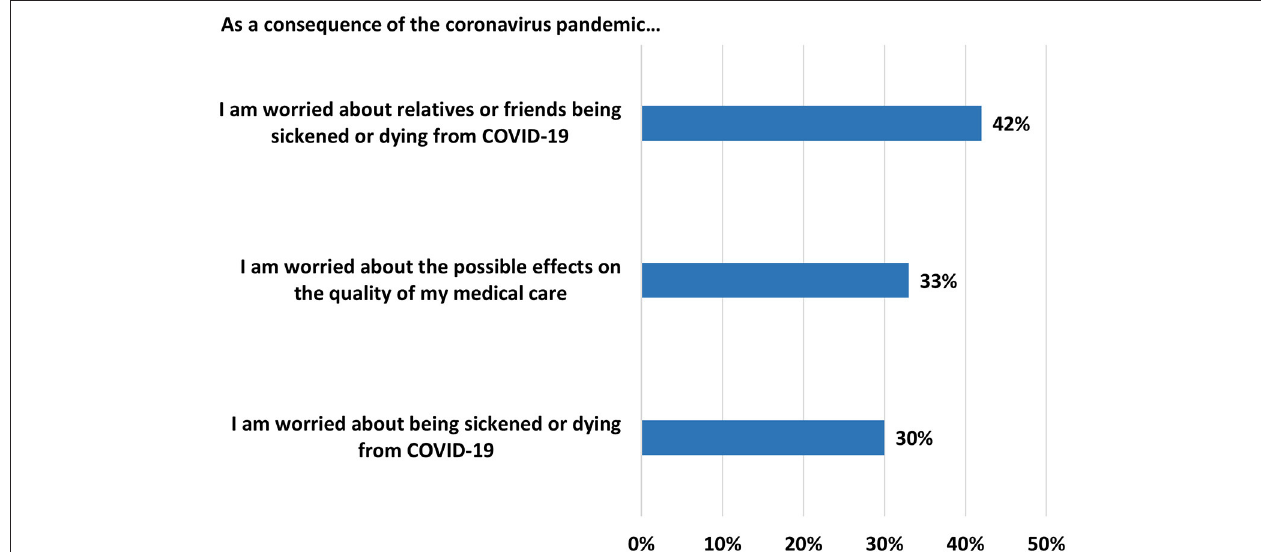
FIGURE 2 | Percent of agreement or strong agreement to subjective concerns during the